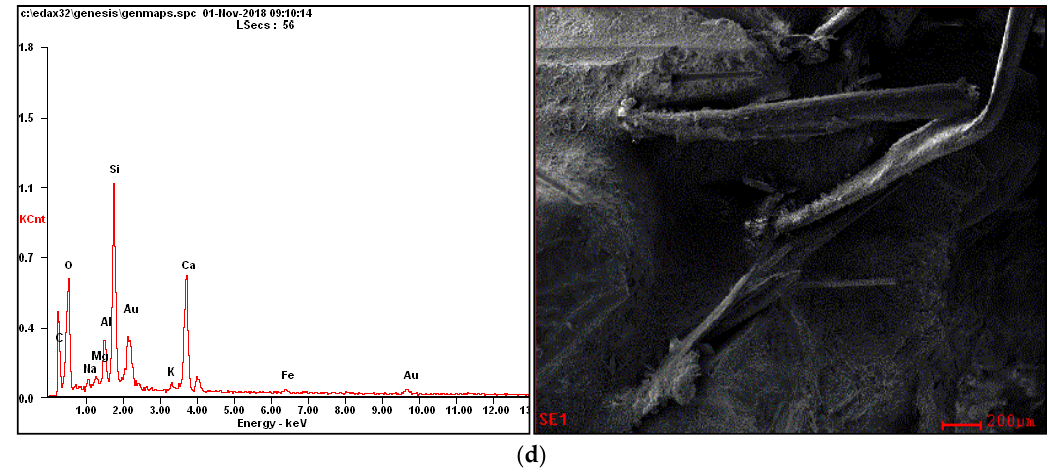
Figure 17. SEM images and energy dispersive X-ray tests of the fibre in the concrete matrix for: ( a ) sample B8, ( b ) sample B3, ( c ) sample C6, and ( d ) sample C9.